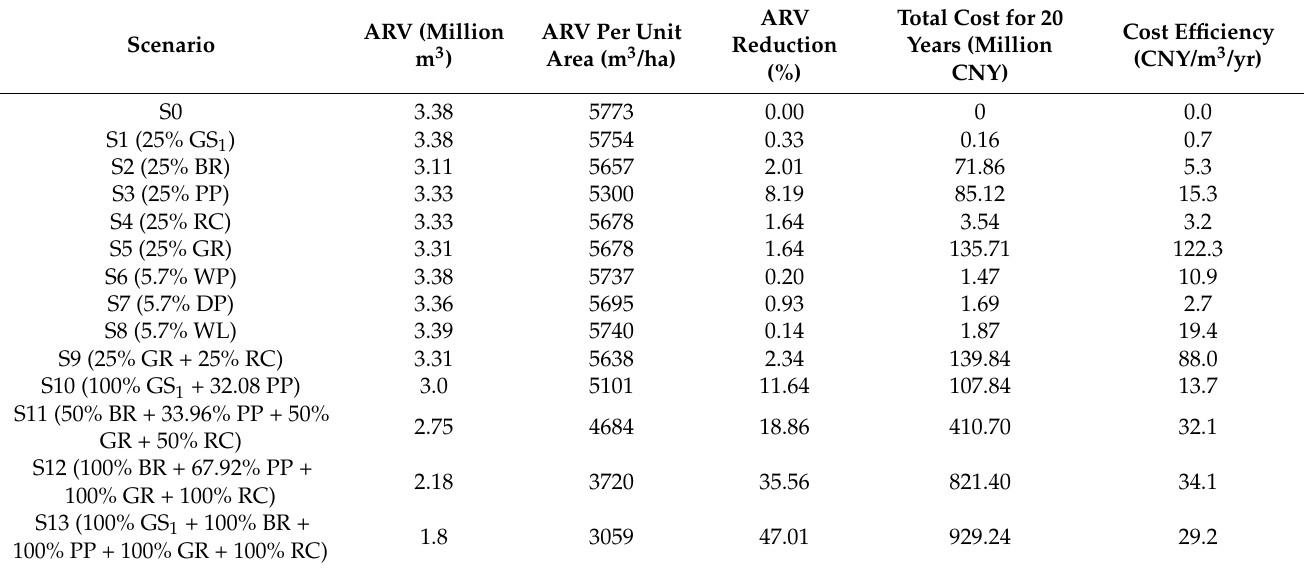
Table 5. Simulation results for the implementation effect of GI practices for each